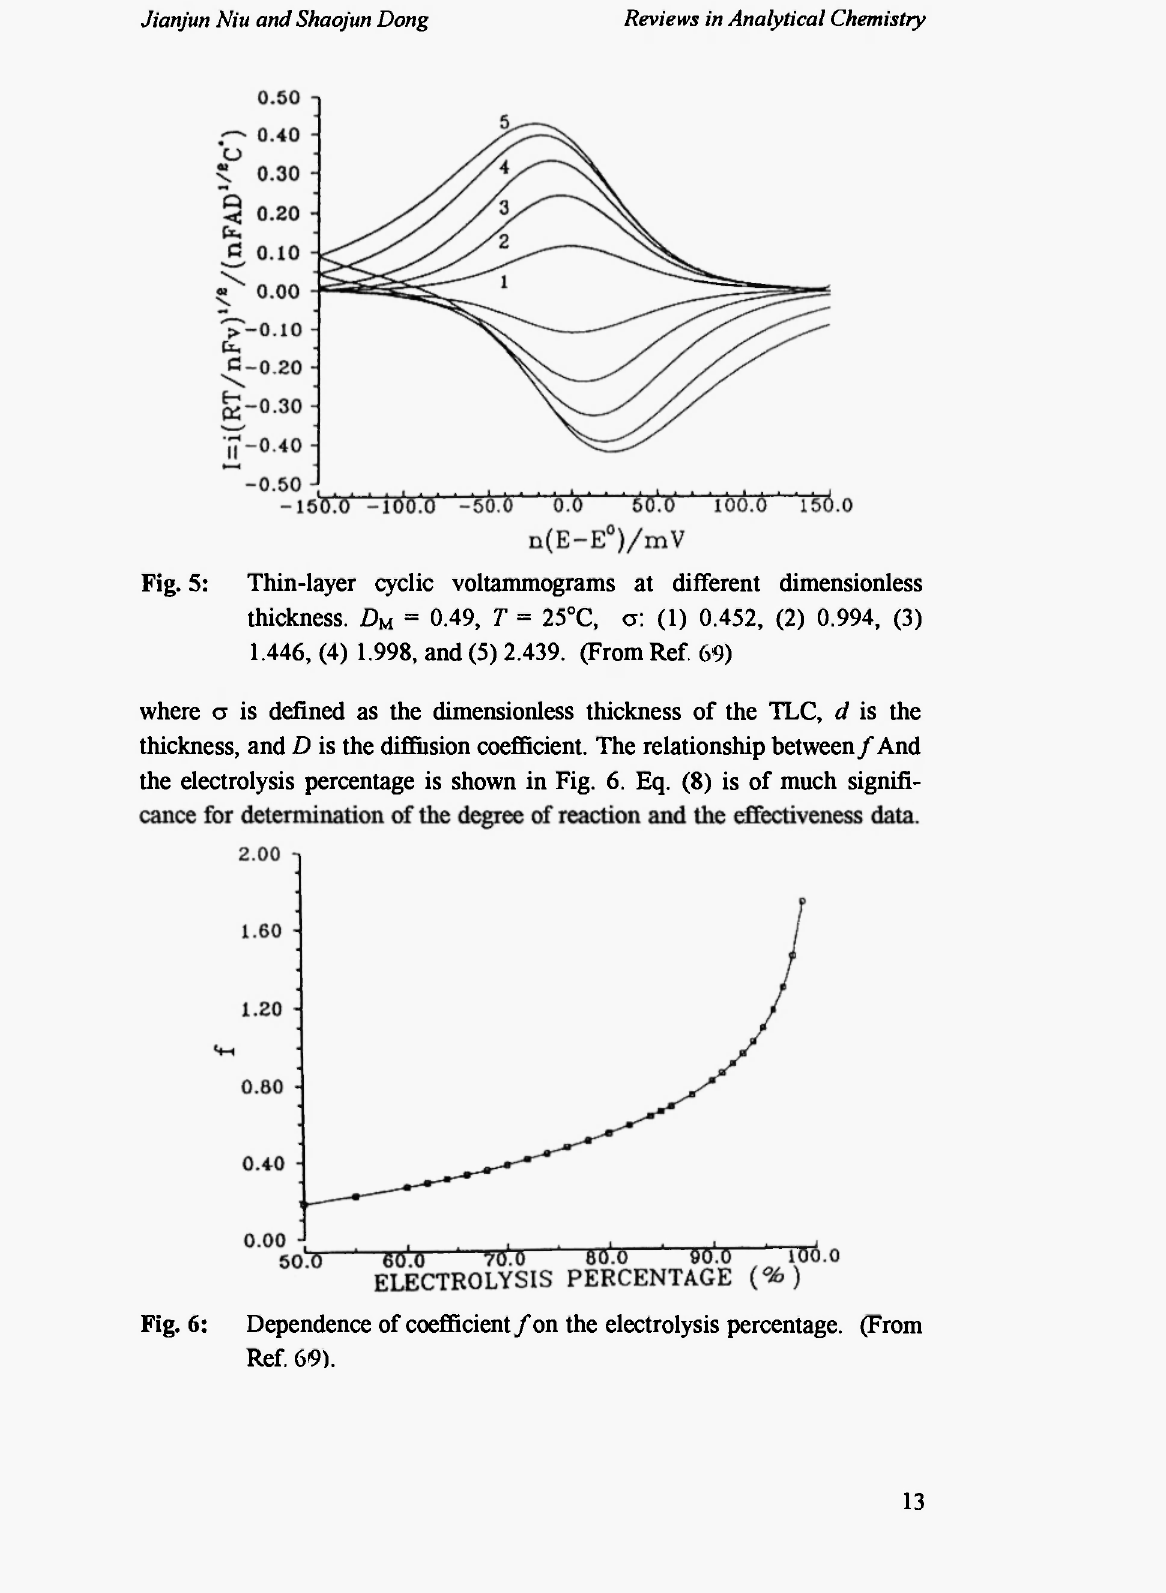
Fig. 5: Thin-layer cyclic voltammograms at different dimensionless thickness. D = 0.49, Τ = 25°C, σ: (1) 0.452, (2) 0.994, (3) u 1.446, (4) 1.998, and (5) 2.439. (From Ref. 69) where σ is defined as the dimensionless thickness of the TLC, d is the thickness, and D is the diffiision coefficient. The relationship between / And